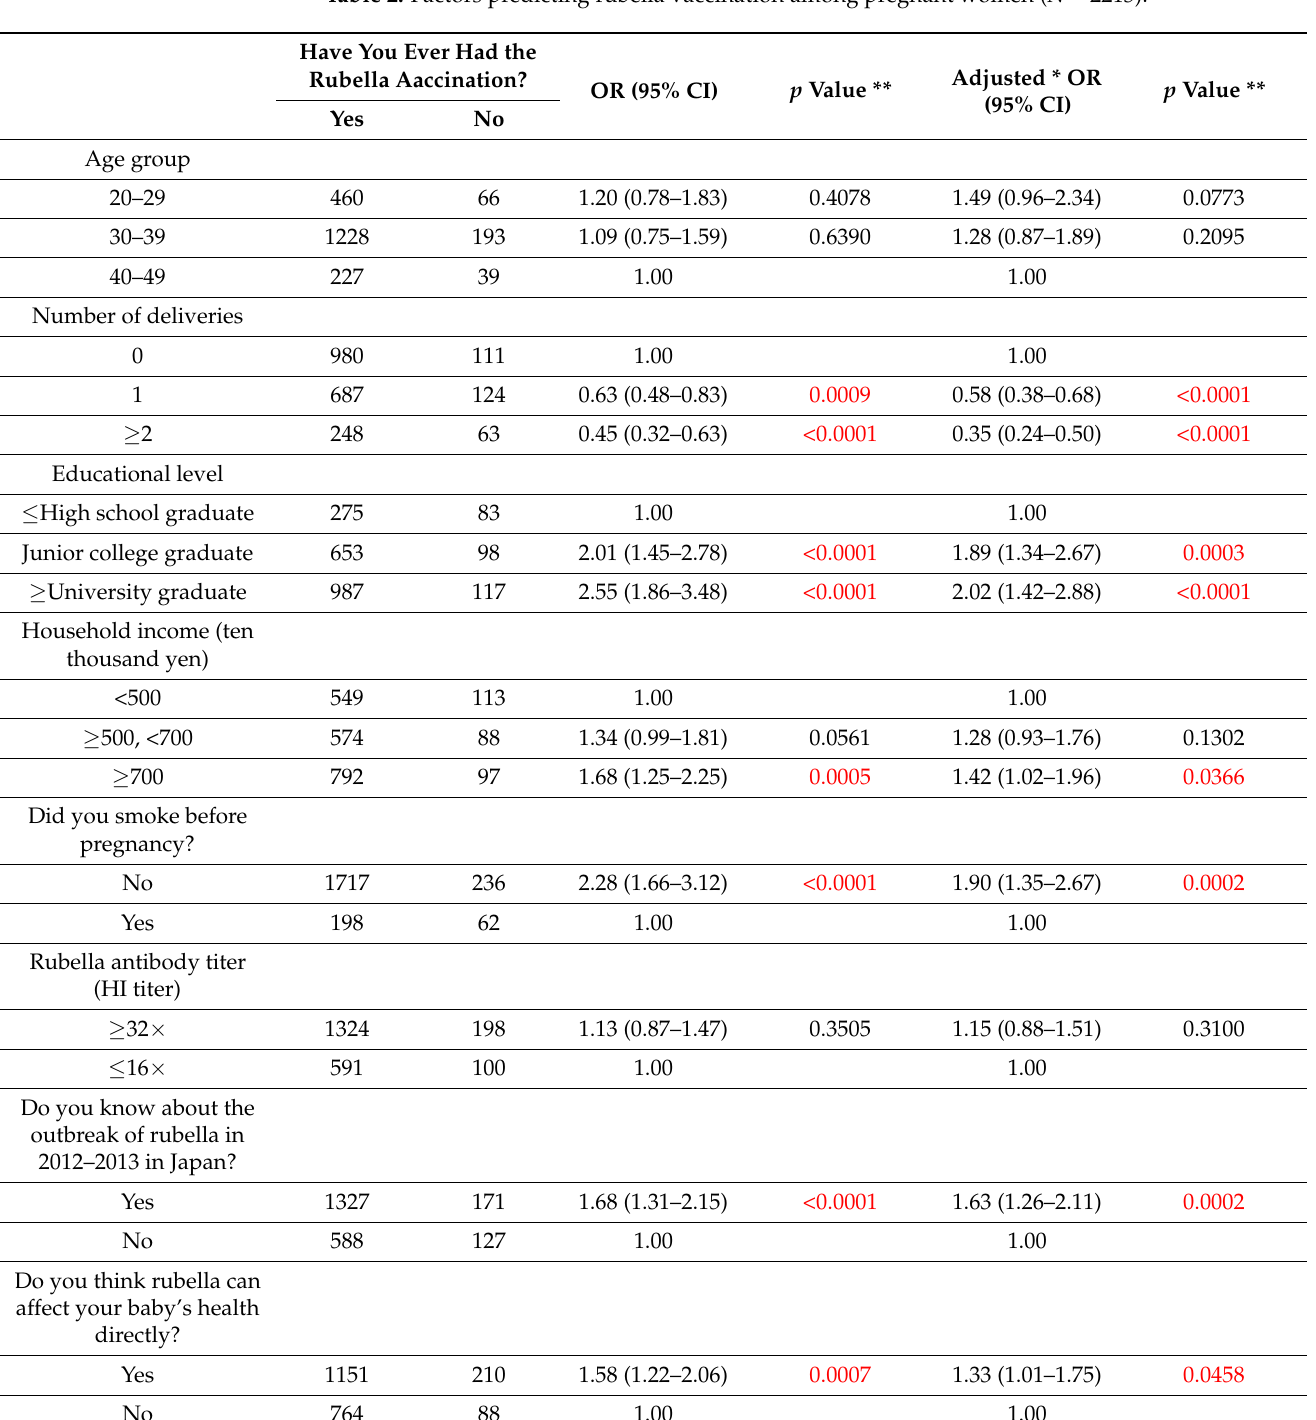
Table 2. Factors predicting rubella vaccination among pregnant women ( N =